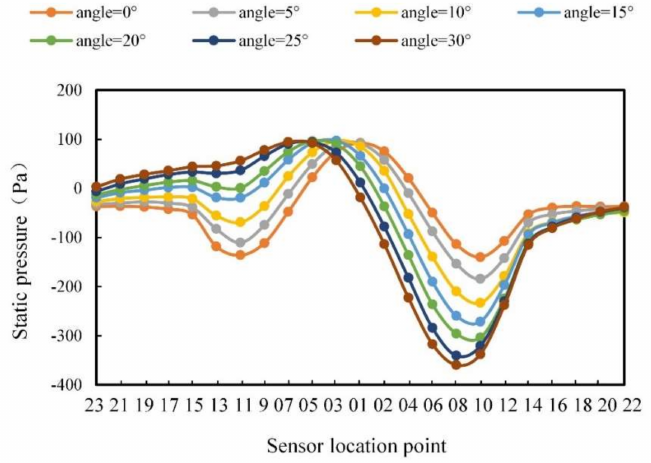
Figure 11. Static pressure curve for di ff erent flow